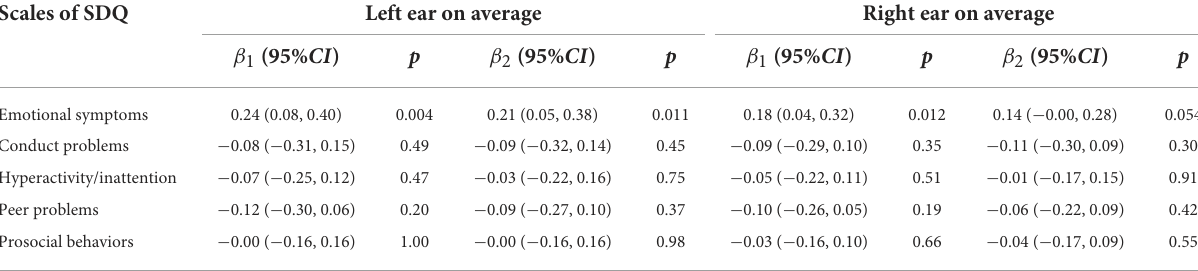
TABLE 3 The association of emotional problems/competence with hearing thresholds among 1,914 children aged 6–8 years in Beijing, China. Scales of SDQ Left ear on average Right ear on average